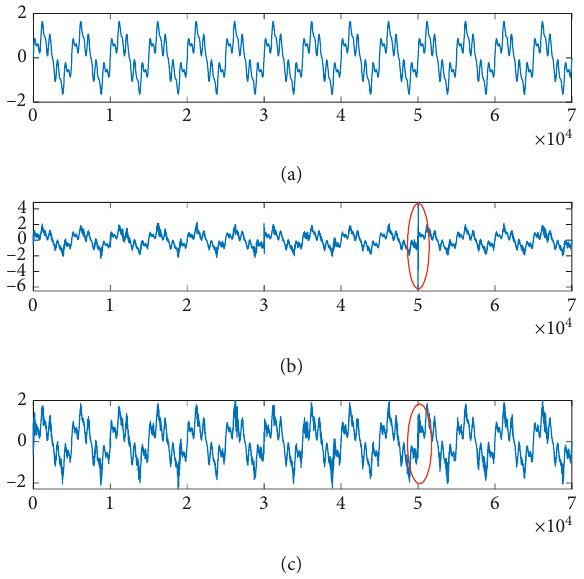
Figure 7: The error signal of the NLMS and the improved LMS algorithms with signal mutation. (a) Signal. (b) e n algorithm. (c) e of the improved LMS algorithm. ( )